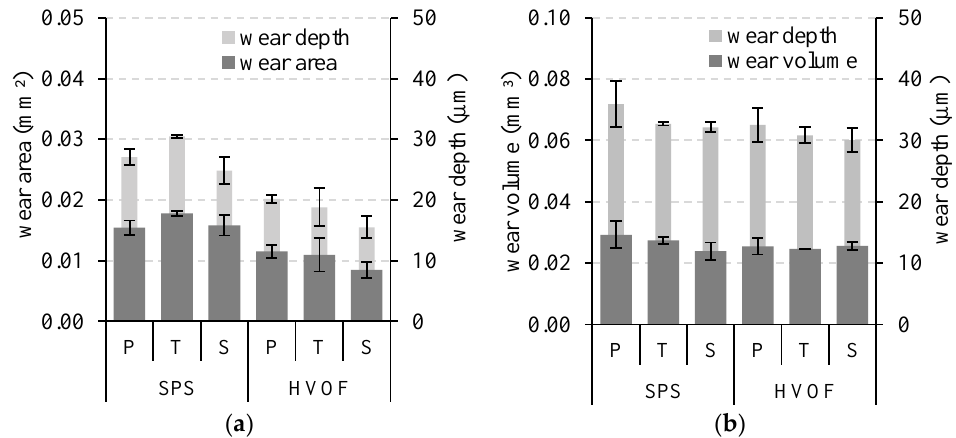
Figure 4. Results of wear investigations of X120Mn12 SPS and HVOF specimen under ( a ) ball-on-disk test and ( b ) reciprocating wear test condition.